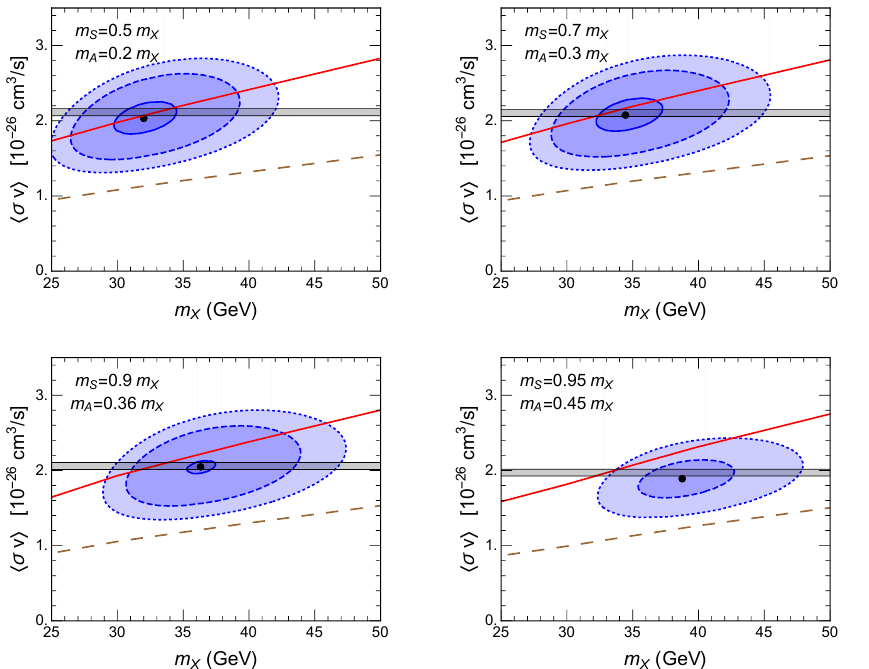
Figure 4 . Allowed parameter regions in the dark matter mass m X and low-velocity annihilation cross section h (cid:27)v i plane. The GC (cid:12)tted regions, shown in the blue color with solid, dashed and dotted boundaries, satisfy p -value (cid:21) 0 : 2 ; 0 : 1 ; 0 : 05, respectively. The black dot marks the GC best- (cid:12)t point. In conventional WIMP scenario, the thermal relic density can be accounted for by the narrowed grey region. All GC results refer to (cid:26) (cid:12) = 0.357 GeV/cm 3 and (cid:13) = 1 : 2. The 95% C.L. upper bound and projected limit from Fermi-LAT observations of dSphs are denoted as the solid red and long-dashed brown lines,